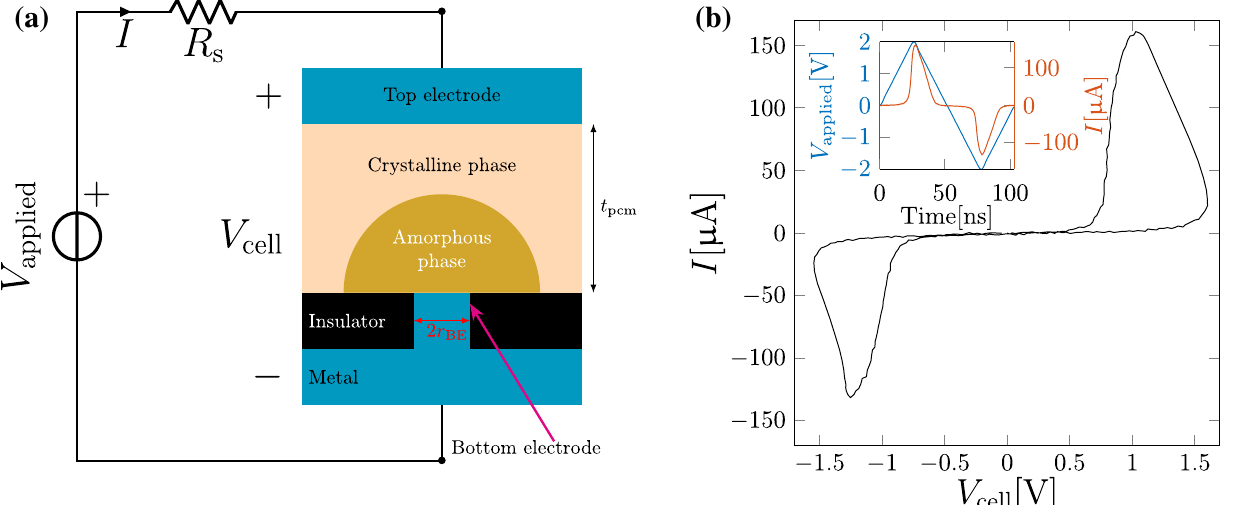
Figure 1. Mushroom-type PCM device and memristive characteristics. ( a ) Schematic representation of a mushroom-type PCM device operated with an integrated current compliance series resistor R s . When the amorphous phase blocks the bottom electrode, the device is in a high-resistance state. The effective thickness of the amorphous region is denoted by u a . V applied is the externally applied input voltage, I is the current flowing V applied R s I is the intrinsic voltage drop on the device. ( b ) The measured through the PCM device and V cell = − current-voltage relationship on the mushroom-type PCM device highlighting the pinched hysteresis loop characteristic of memristive